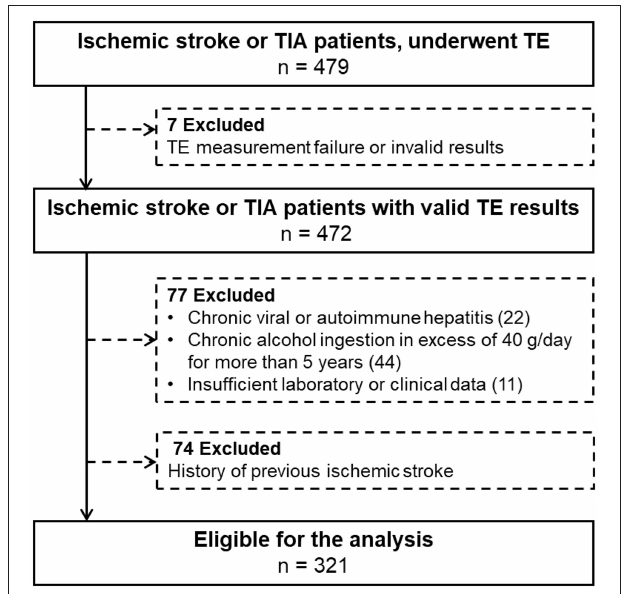
FIGURE 1 | Patient